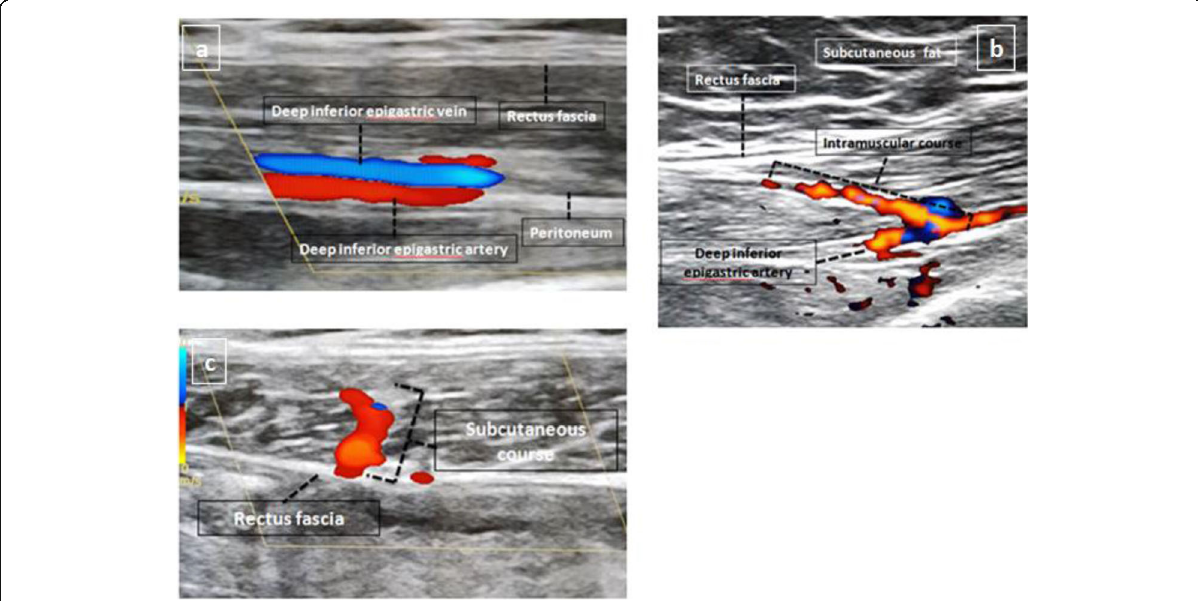
Fig. 1 CDUS showing the deep inferior epigastric artery and vein in the longitudinal plane ( a ) and the intramuscular ( b ) and subcutaneous ( c ) courses of a dominant perforator as it pierces the rectus